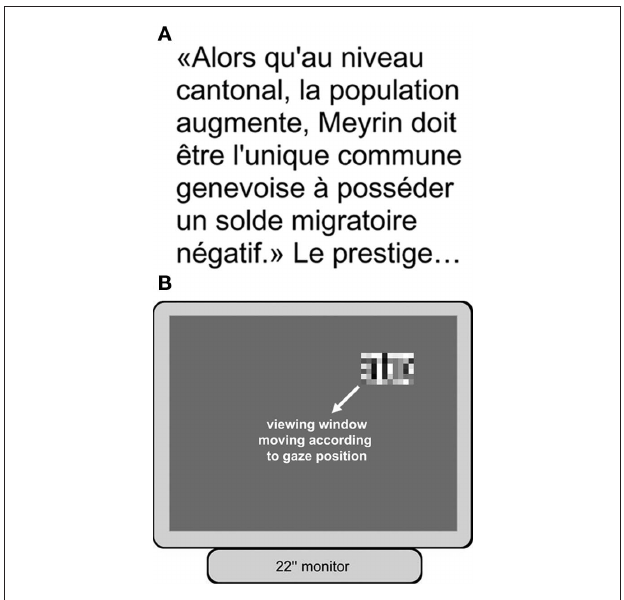
Figure 1 | experimental setup and procedure. Subjects had to read pages of text visible only through a low-resolution, restricted viewing window. The viewing window moved following the subject’s center of gaze, and its content was updated accordingly. (A) Example of one of the text pages read by the subjects. (B) Illustration of the stimulation screen as viewed by the subject during the